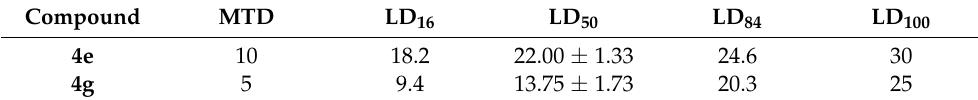
Table 6. The body weight changes of BDF 1 hybrid mice after a single intraperitoneal injection of 4e . Dose,